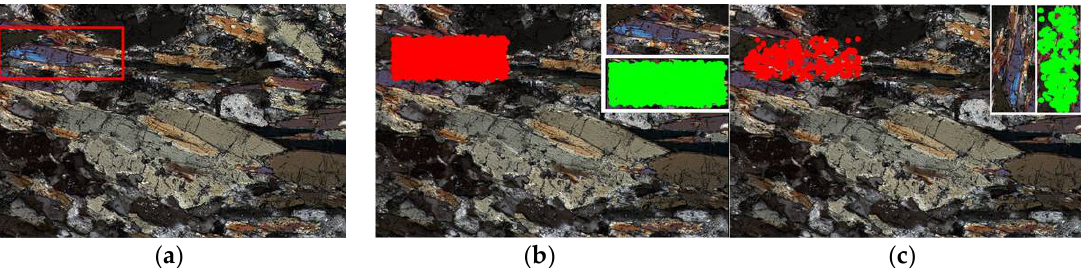
Figure 7. Microscopic image of amphibolite from Spitsbergen with marked fragment—search query ( a ). Effects of the detection of interest points using query image (green points) and original image (red points), when using: selected fragment ( b ), rotated and scaled fragment ( c ) (magnification: ×100).